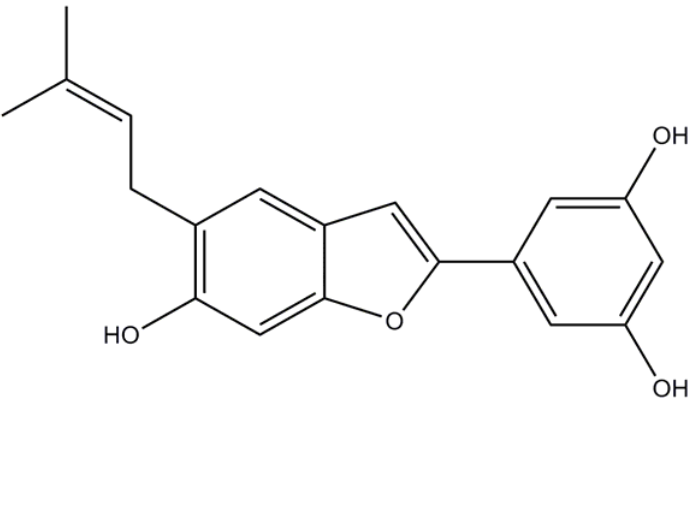
Figure 5. Chemical structure of moracin N identified in induced mulberry leaves (Peak